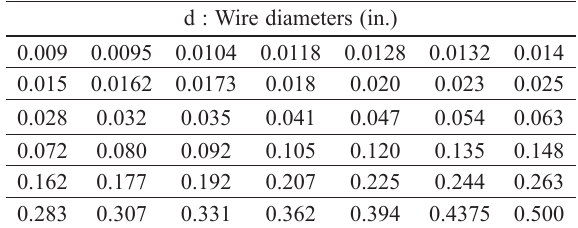
Table 7. Discrete values of the spring wire diameters d : Wire diameters (in.)